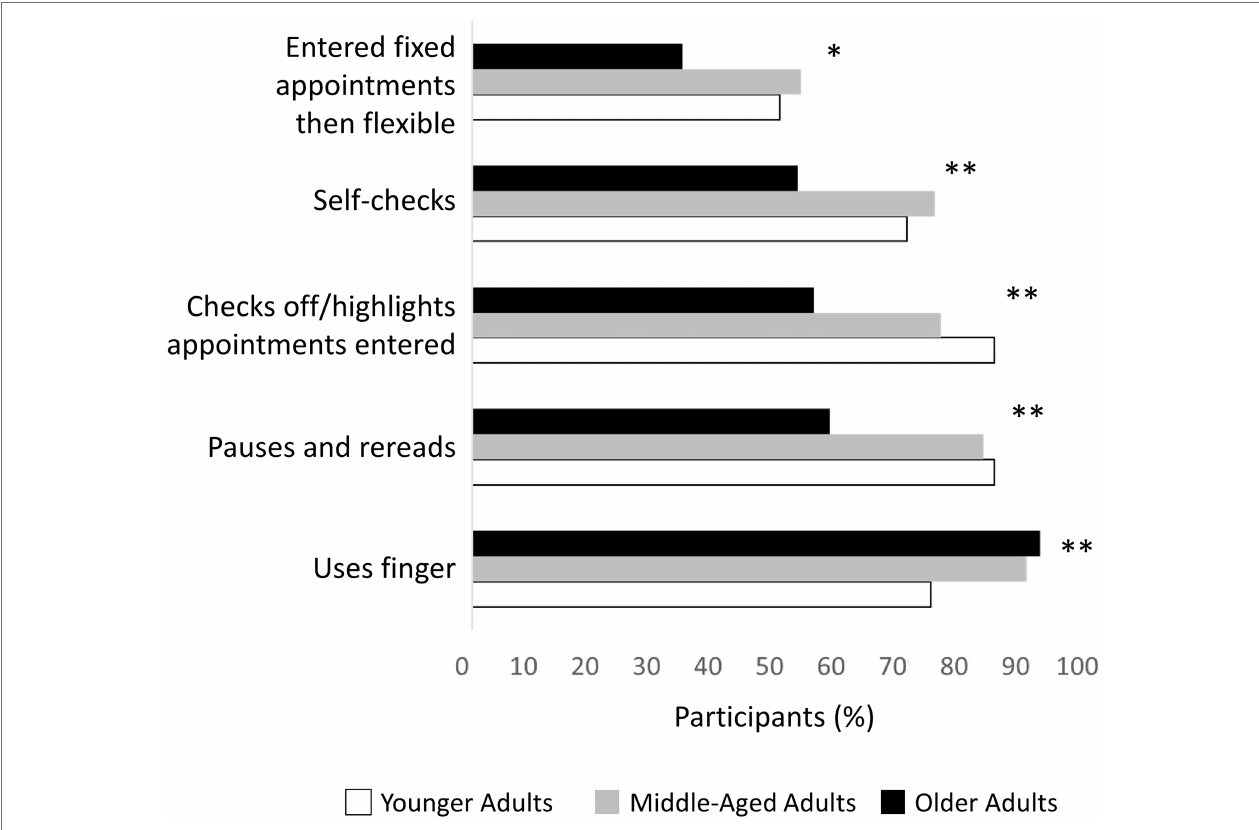
FIGURE 1 | Type and frequency of strategies used across the adult lifespan. Strategies were restricted to those used by 50% of participants in at least one age group. * p < .05; ** p <